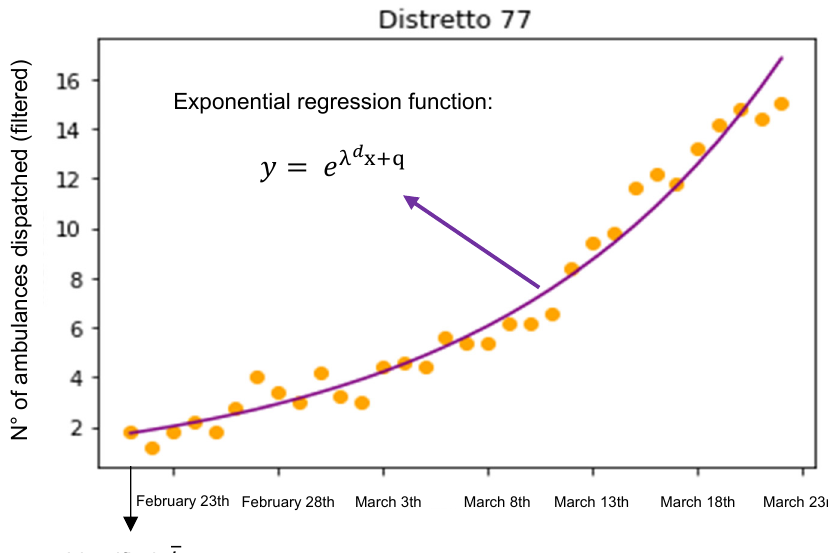
Figure 1. Data representing the daily number of ambulances dispatched in a district, which were filtered with a 5-day moving average and plotted; the day t d is identified as the earliest day where the exponential regression function ( y = e λ d x + q ) had a correlation coefficient R 2 > 0.9, and the λ d parameter of such a function (computed from t d ) was considered as the estimator of the speed of the COVID-19 pandemic diffusion.